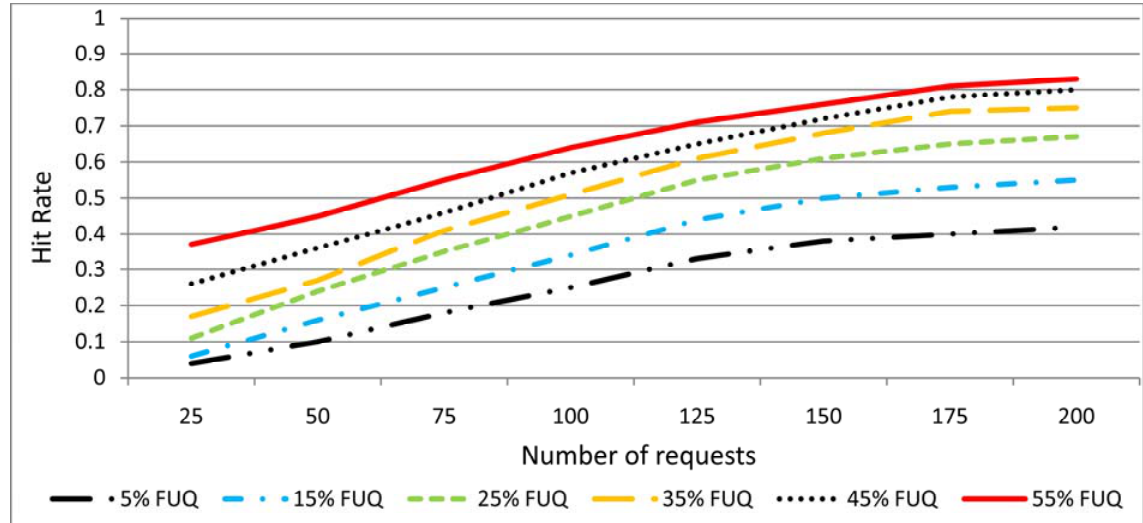
Fig. 9: Hit rate per number of requests